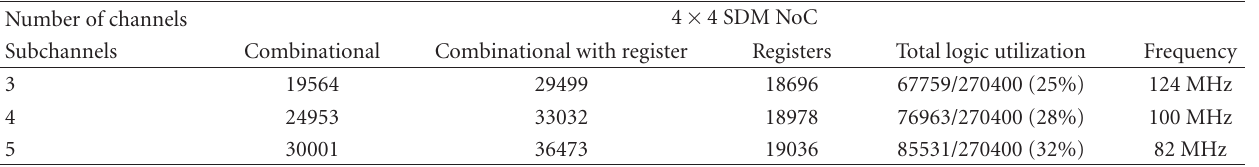
Table 7: Synthesis results 4 × 4 SDM-based NoC.